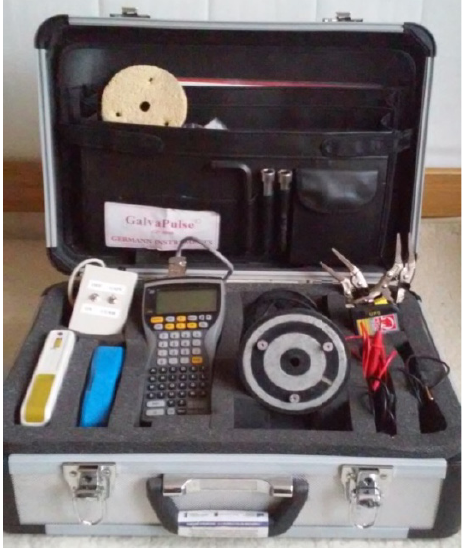
Figure 2. The GP-5000 GalvaPulse TM set.